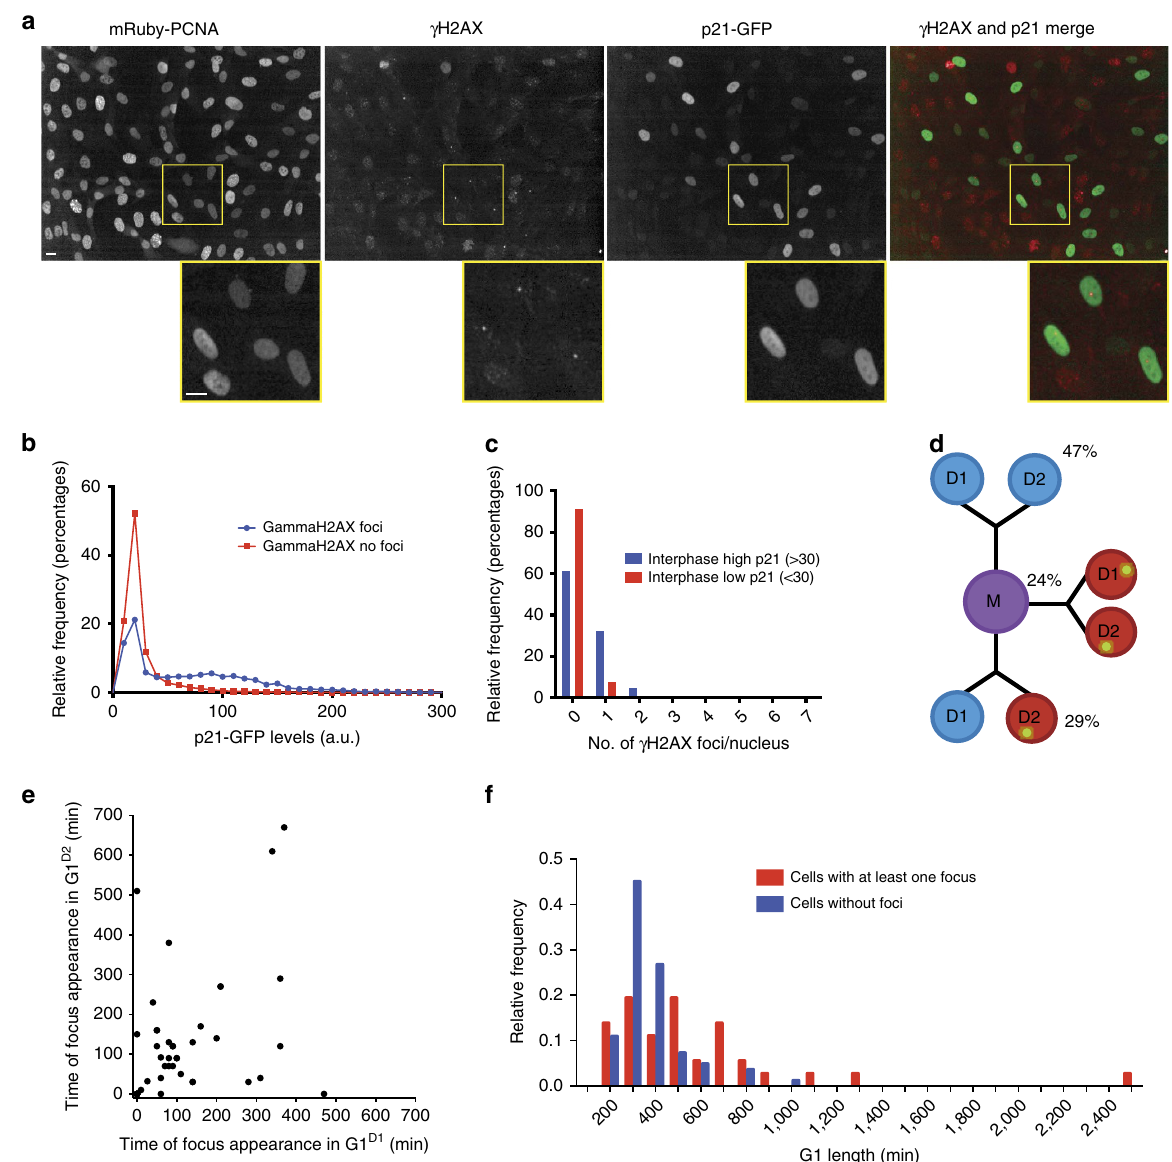
Figure 3 | Basal p21 expression correlates with the presence of DNA damage foci. ( a ) Images of hTert-RPE1 mRuby-PCNA p21-GFP cells fixed and stained for g H2AX. Magnified regions of each image are also shown. p21-GFP is green, g H2AX is red in merged images. Scale bars are 10 m m. ( b ) Quantification of p21-GFP nuclear fluorescence in interphase (excluding S-phase) cells with or without g H2AX nuclear foci. With foci, n ¼ 2086 cells; without foci, n ¼ 12476. ( c ) Quantification of number of g H2AX foci per nucleus after separation of cells based on a high or low p21-GFP nuclear fluorescence (high p21 4 30a.u.). High p21-GFP, n ¼ 3896 cells; low p21-GFP, n ¼ 11049. ( d ) Fates of sister cells pairs (D1 and D2) with regards to 53BP1 focus appearance. 142 daughter pairs were analysed. ( e ) Correlation between the time of 53BP1 focus appearance in sister cells. 45 sister pairs are shown. Note: 14 sister pairs are clustered at time 0,0min and are not visible as separate values. Pearson’s Correlation R ¼ 0.39* ( P o 0.05). ( f ) Histogram of G1 length separated by the presence or absence of a 53BP1-GFP focus. The difference between the two populations is significant (unpaired student’s t -test P ¼ 0.0003). 118 cells were scored